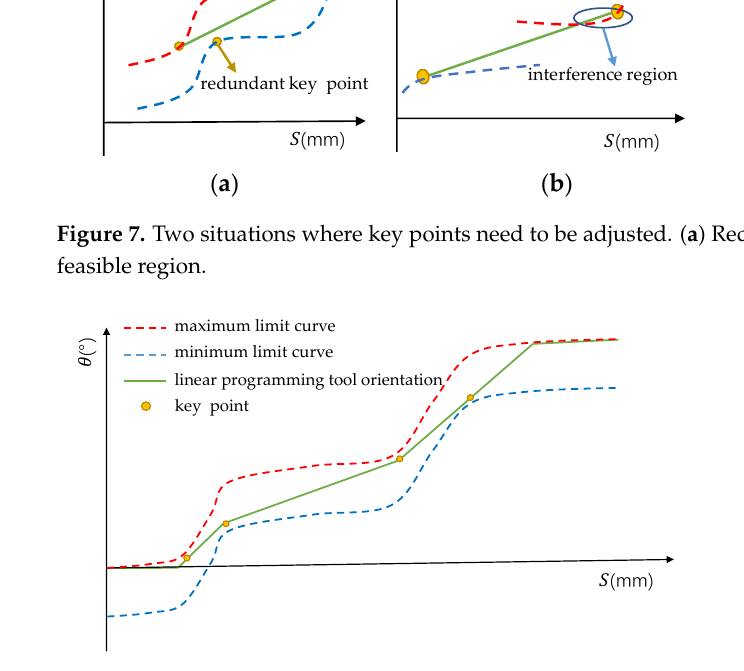
Figure 8. Results of piecewise decoupled linearization scheduling.